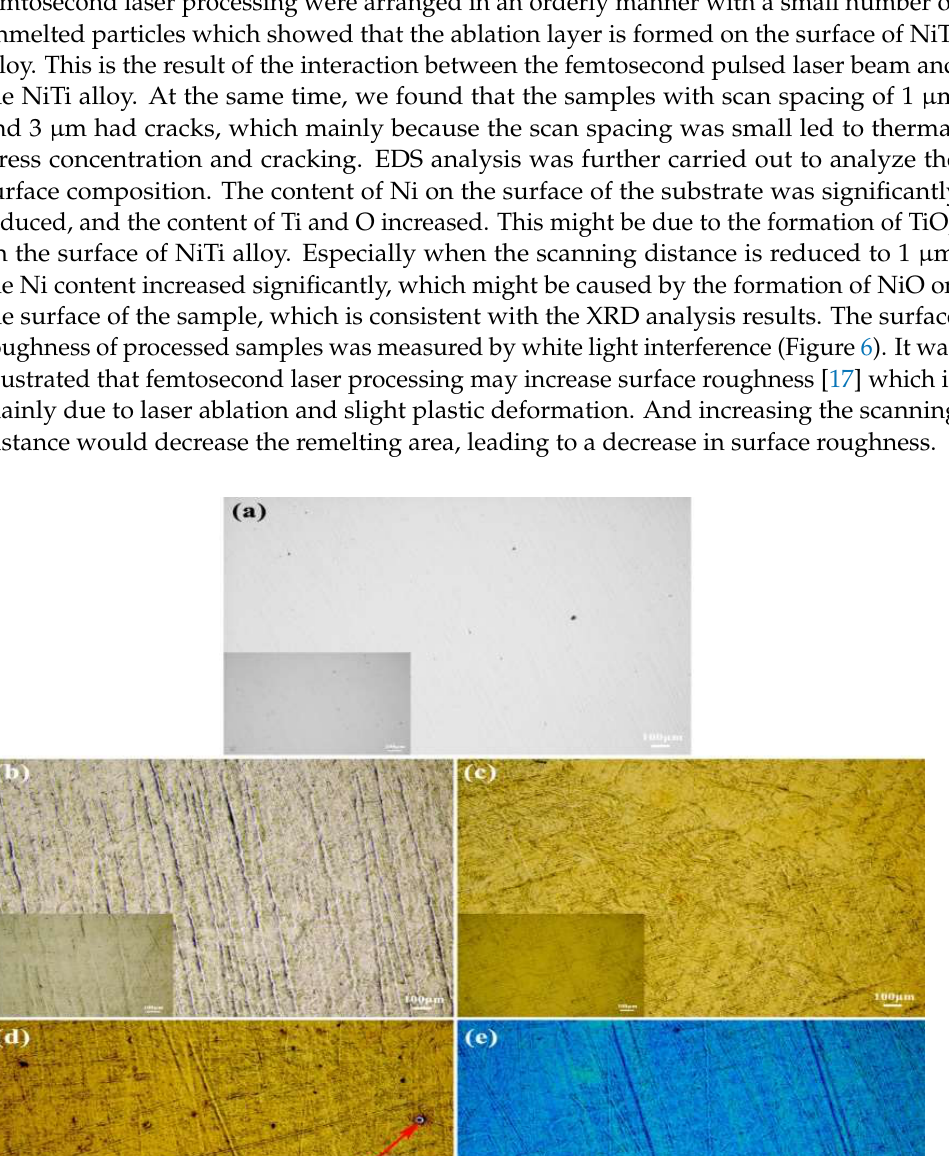
Figure 5. SEM image of samples before and after femtosecond laser ( a ) As-fabricated ( b ) 10 μm. ( c ) 5 μm ( d ) 3 μm ( e ) 1 μm.